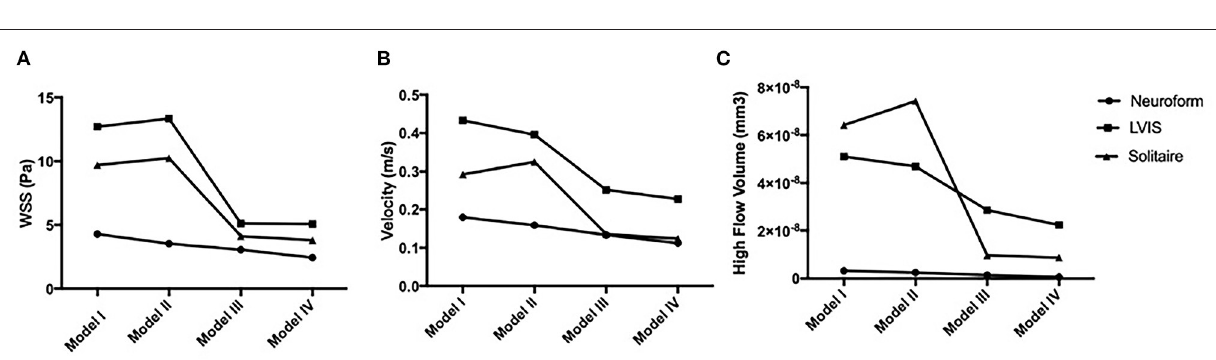
FIGURE 6 | Hemodynamic characteristics of four models for Solitaire stenting of an unruptured A2/3 bifurcation aneurysm are revealed. Velocity in Model II increased significantly while wall shear stress and high flow volume in Model II do not change significantly compared with Model I. Wall shear stress, velocity, and high flow volume in Models III and IV decreased significantly compared with Model I.